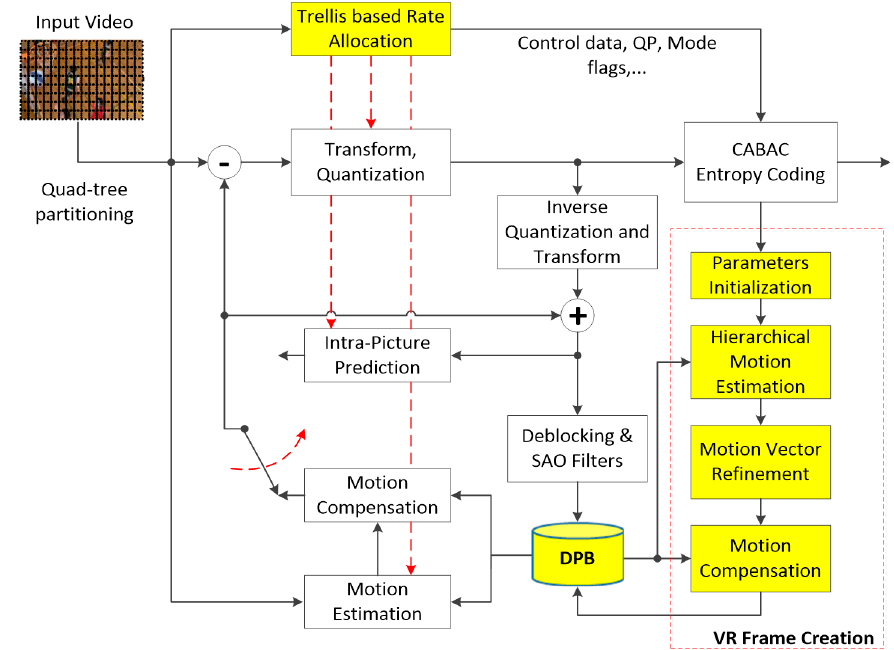
Figure 3. Proposed HEVC architecture